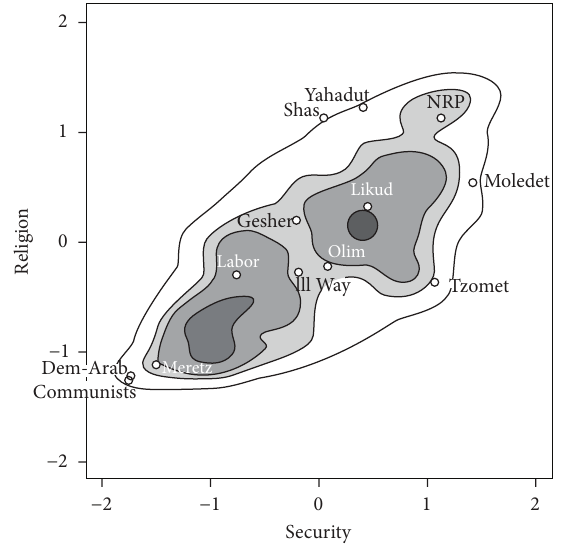
Figure 6: Party positions and voter distribution in Israel in the 1996